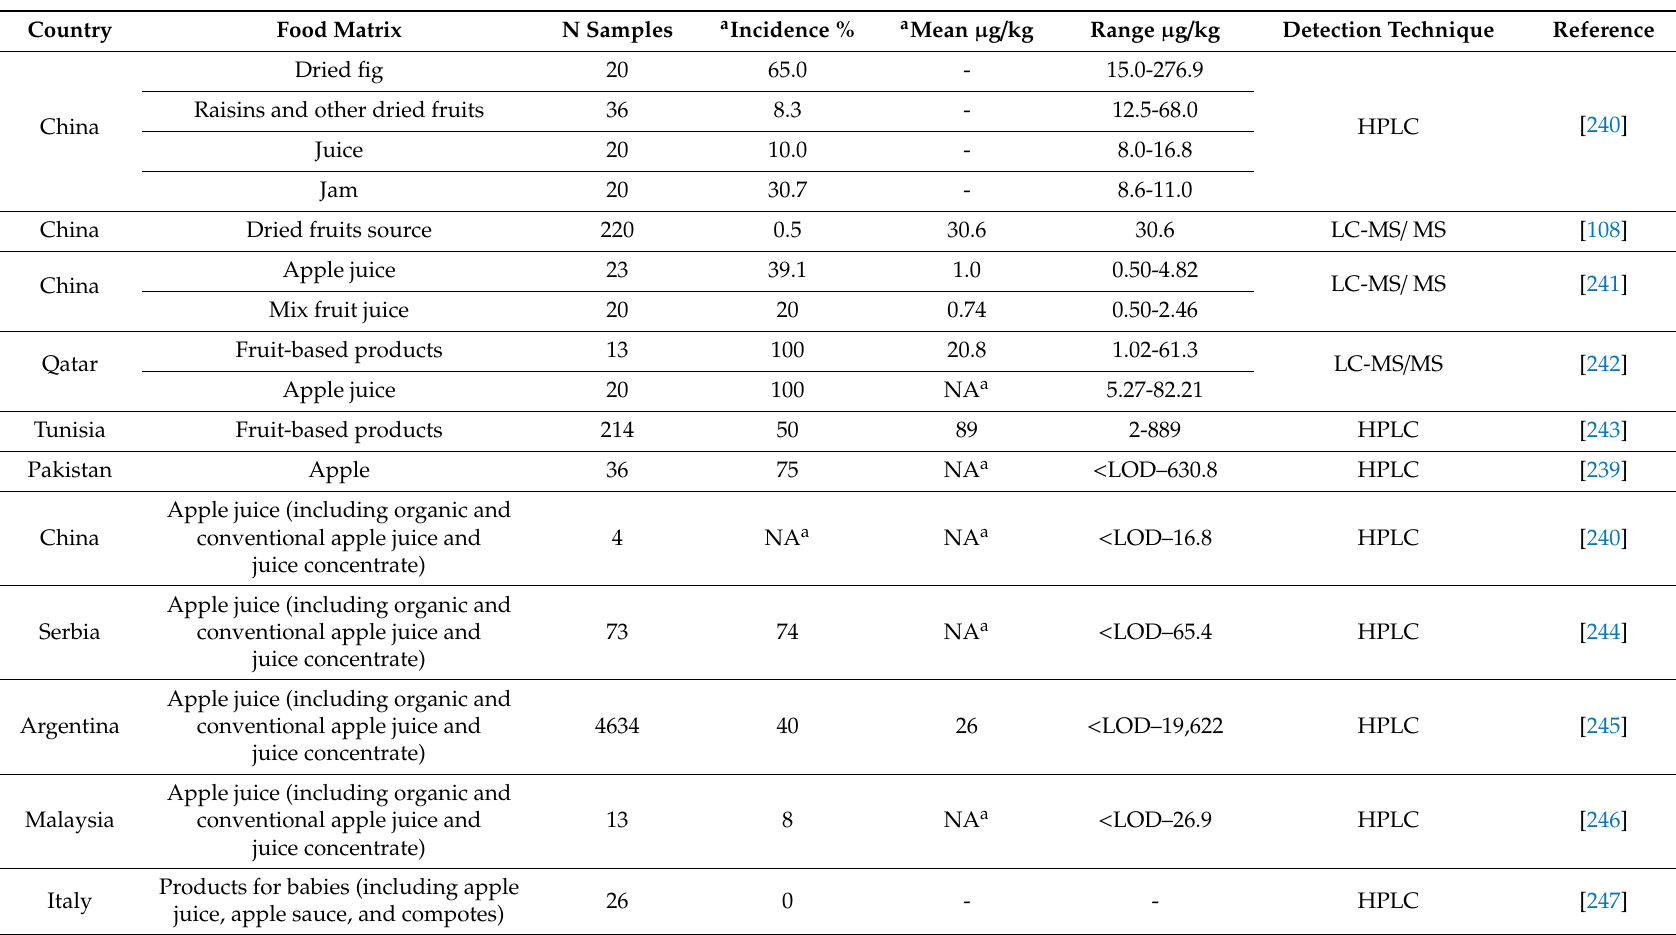
Table 12. Representative studies on the occurrence of PAT distribution ( µ g / kg or µ g / L) in food samples around the world during 2014–2019. Country Food Matrix N Samples Detection Technique